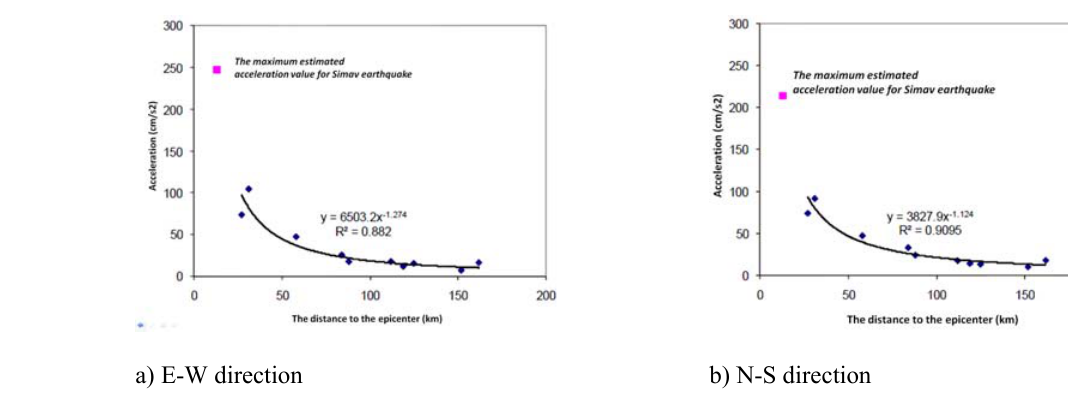
Fig. 1. Tectonics of the region and distribution of earthquake epicenters (AFAD, 2011).